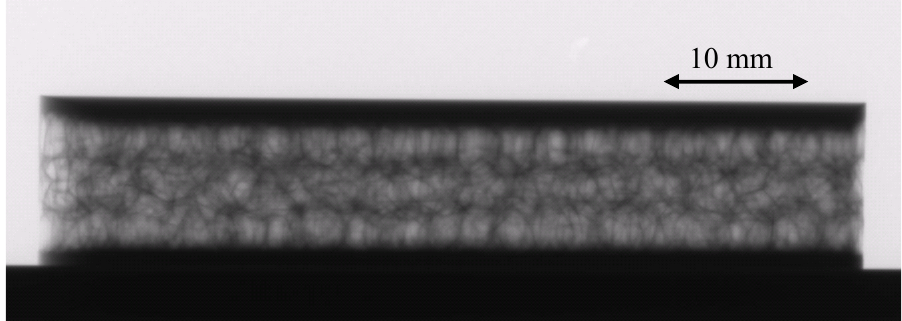
Figure 4. X-ray radiography of an aluminum foam sandwich (AFS) produced by the company “metalfoam” exhibiting three vertically aligned bubble